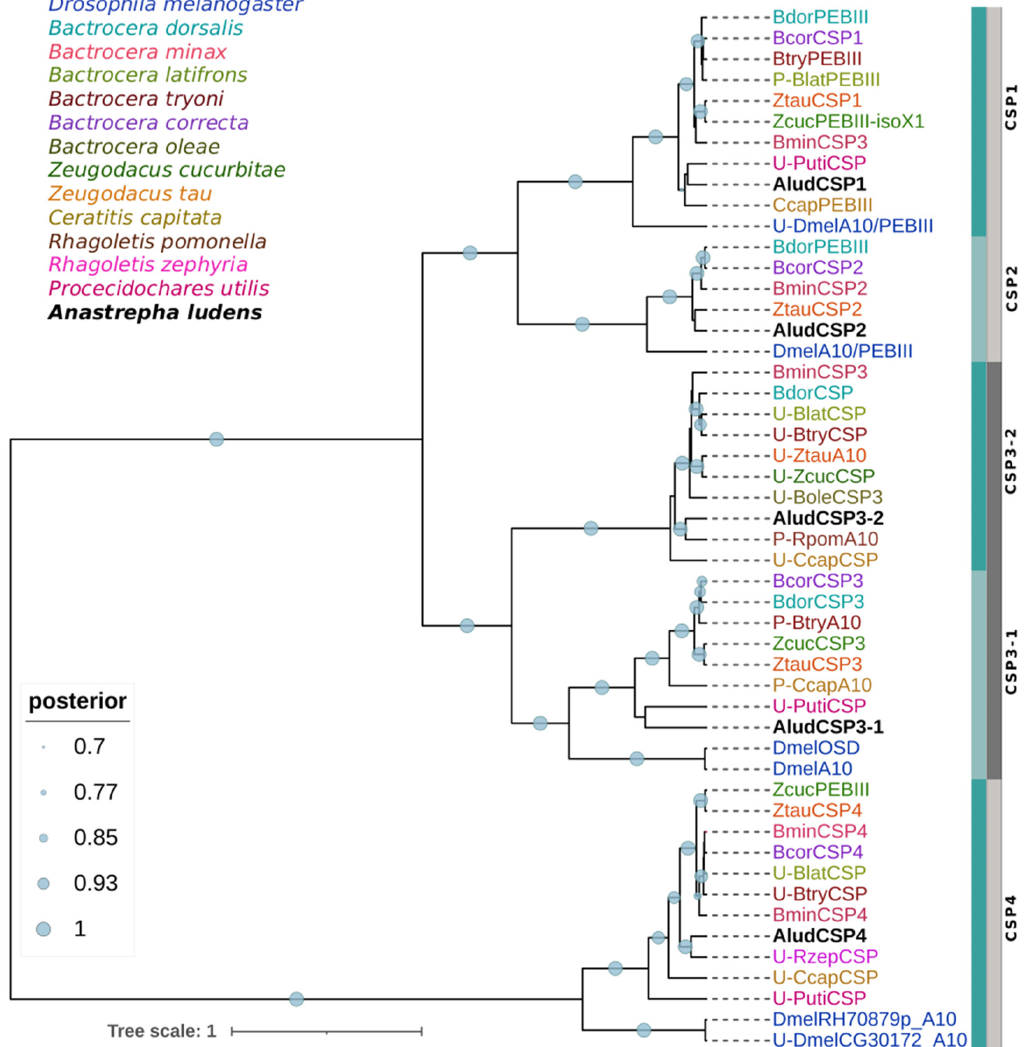
Figure 3. Bayesian phylogenetic analysis of candidate CSPs of Anastrepha ludens with homologs from twelve dipteran species and the model organism Drosophila melanogaster . Blue and gray bars delimit the branch expansions of the AludCSPs and their orthologues. Circles showed posterior probability values over 70%. Letters “U-” and “P-” refer to sequences in the databases that are uncharacterized or were automatically annotated by the genomic sequence prediction method.